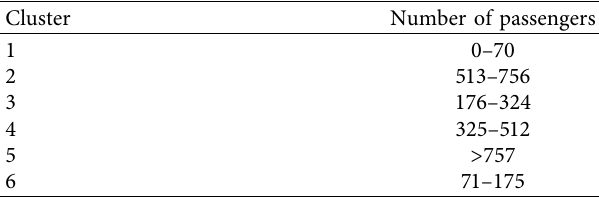
Table 9: Validation of statistic model.